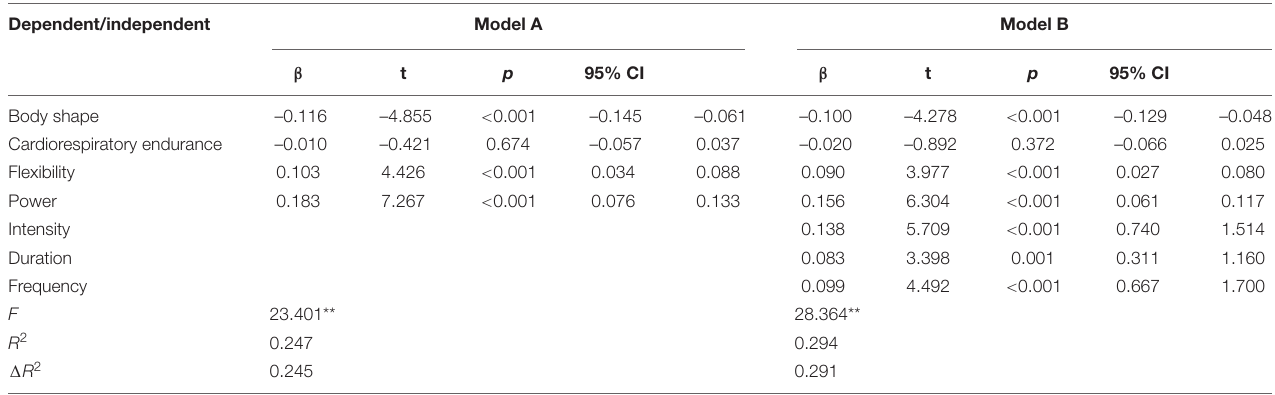
TABLE 5 | Hierarchical multiple regression analysis of physical fitness, self-efficacy, and exercise behavior ( N = 1,923).